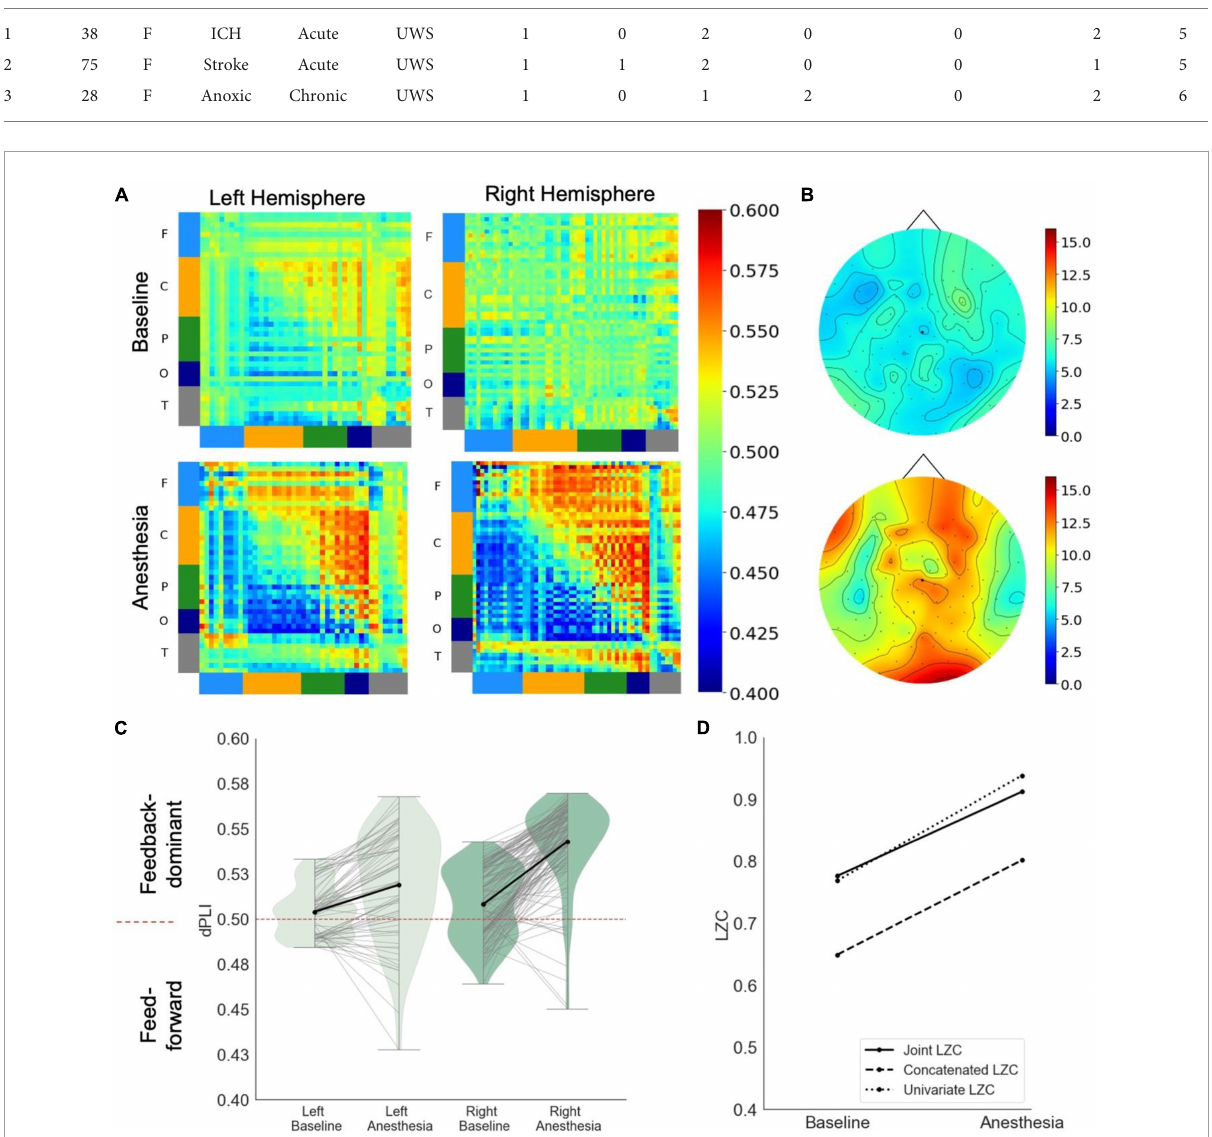
FIGURE1 Case 1 (A) directed functional connectivity (dPLI) within the right and left hemisphere during baseline and anesthesia. Electrodes are ordered per region: F, frontal; C, central; P, parietal; T, temporal; O, occipital (B) network hubs during baseline and anesthesia. (C) Directed functional connectivity (dPLI) between frontal and parietal regions within the left and right hemisphere. Light gray lines represent individual electrodes, black lines represent the mean. (D) Three types of Lempel-Ziv complexity and its propofol-induced